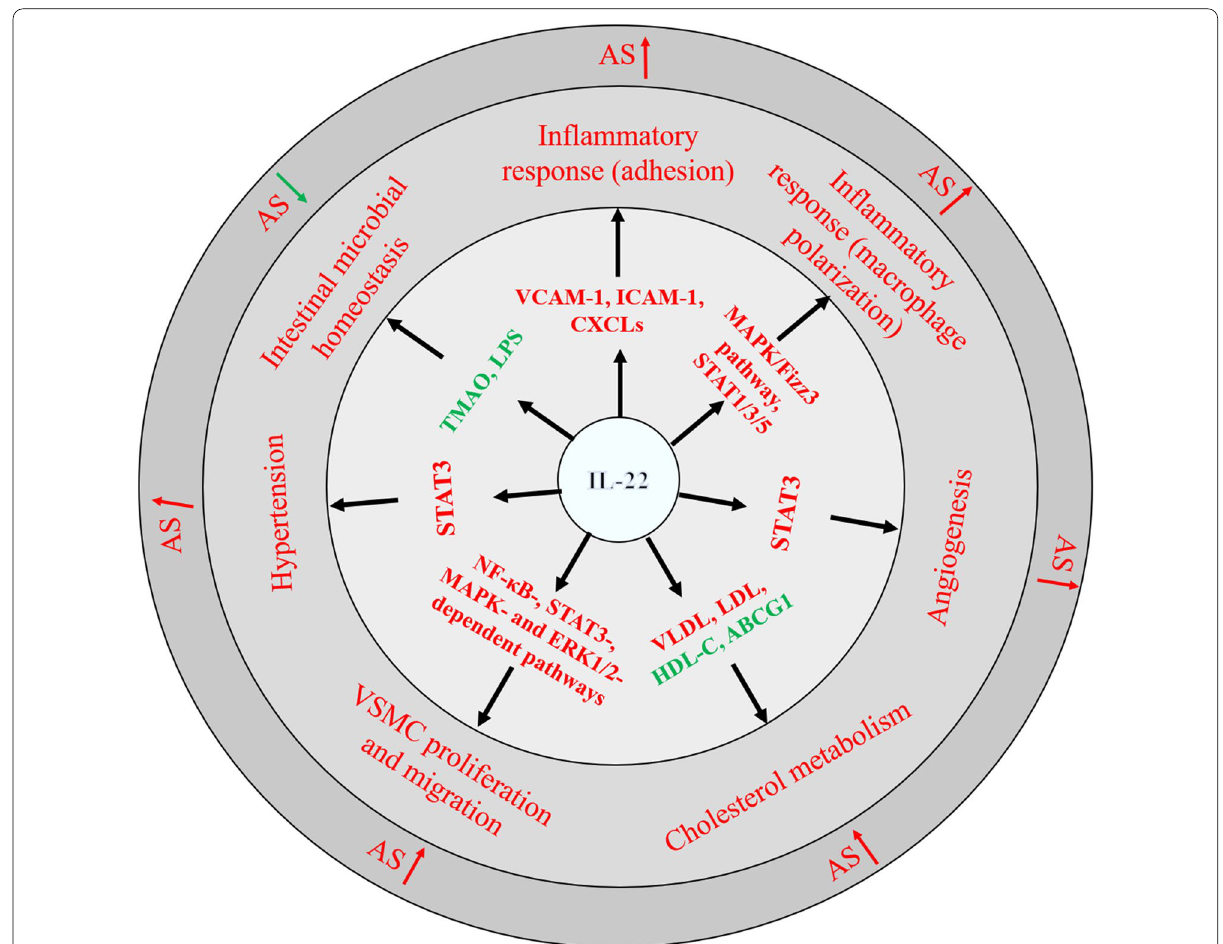
Fig. 1 IL‑22‑mediated regulation and the major cardiometabolic risk factors of atherosclerosis. VCAM-1 vascular cell adhesion molecule‑1, ICAM-1 Intercellular adhesion molecule‑1, CXCLs CXC chemokine ligands, MAPK mitogen‑activated protein kinase, STAT signal transducer and activator of transcription, VLDL very low‑density lipoprotein, LDL low‑density lipoprotein, HDL-C high‑density lipoprotein cholesterol, ABCG1 ATP‑binding cassette transporter G1, NF-κB nuclear transcription factor‑κB, ERK extracellular signal‑regulated kinase, VSMC vascular smooth muscle cell, TMAO trimethylamine N‑oxide, LPS lipopolysaccharide, AS atherosclerosis. Arrows in red: promote; Arrows in green: inhibit; text in red: proatherogenic changes; text in green: antiatherogenic